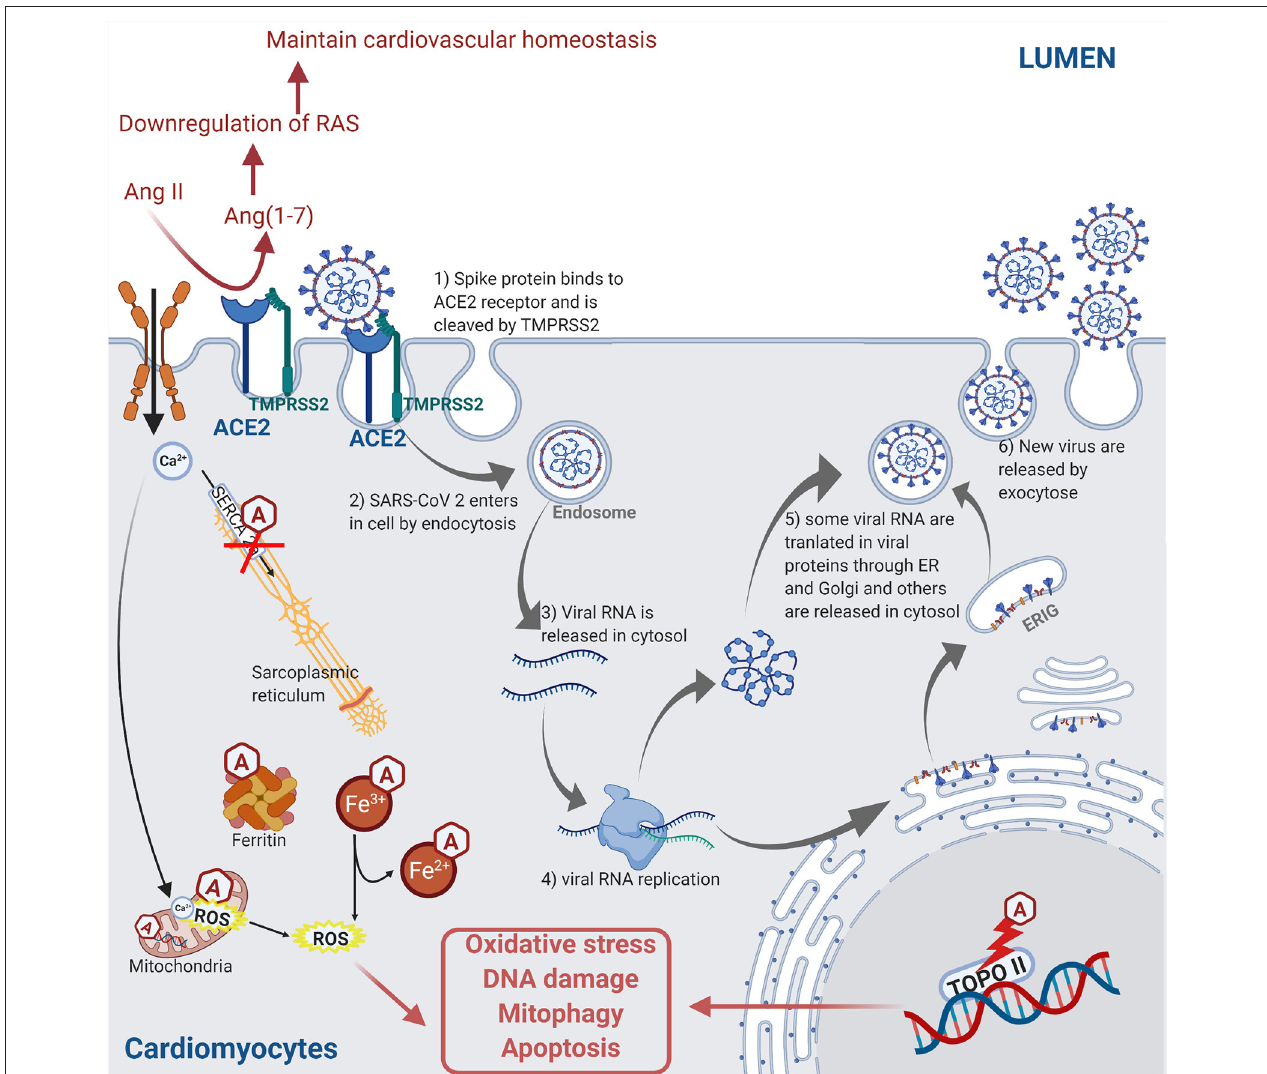
FIGURE 4 | Molecular mechanisms involved during anthracycline (Hexagonal box with “A”) treatment and SARS-CoV-2 infection in cardiomyocyte leading to injury. Anthracycline can bind to nuclear and mitochondrial DNA and interfere with the cell replication process. The TOPO II enzyme can be inhibited by anthracycline, leading to the damaged DNA during cell replication. Anthracycline can also disturb the Ca 2 + influx into the cell. The disruption of Ca 2 + homeostasis by anthracycline in the mitochondria leads to an increase of reactive oxygen species (ROS) production and oxidative stress. Moreover, the expression of the Ca 2 + pump SERCA2a in the sarcoplasmic reticulum is decreased by anthracycline, which induces contractile dysfunction. Anthracycline can also prevent the release of iron from ferritin and facilitate the reduction of anthracycline–Fe 3 + complexes leading to ROS production. Combined, these anthracycline mechanisms lead to increased ROS production, DNA damage, and contractile dysfunction, which leads to cellular apoptosis. Please refer to Figure 2 legend for a detailed description of the SARS-CoV-2 pathway (figure created with Biorender.com).